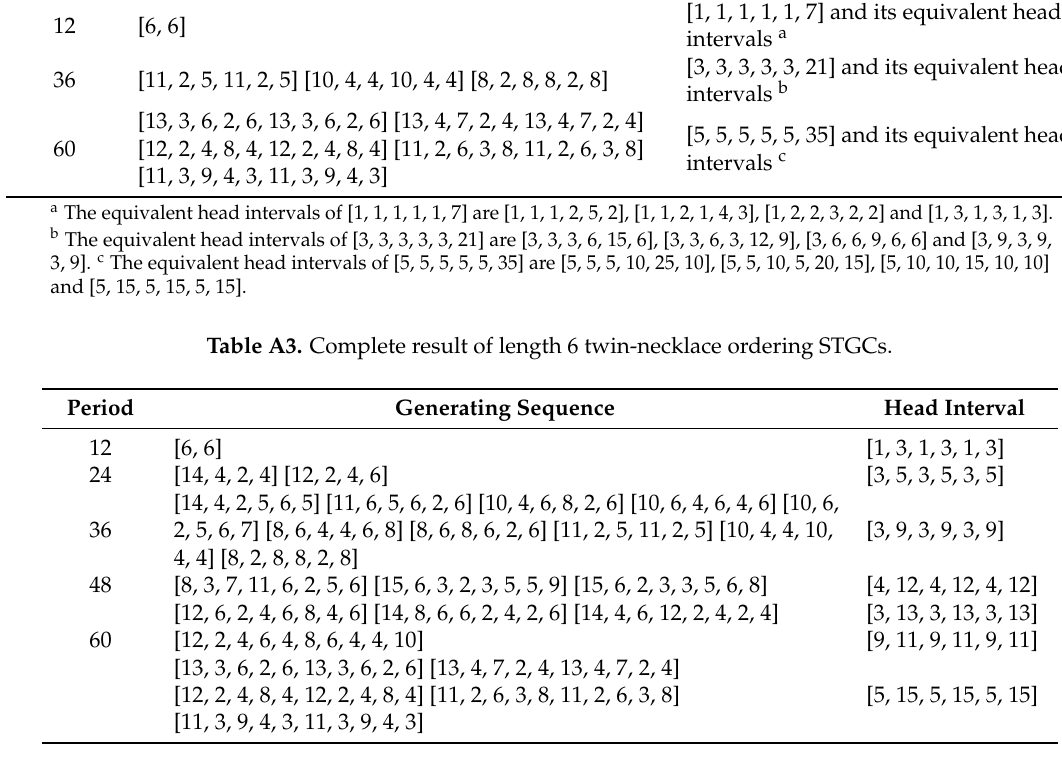
Table A4. Complete result of length 6 triplet-necklace ordering